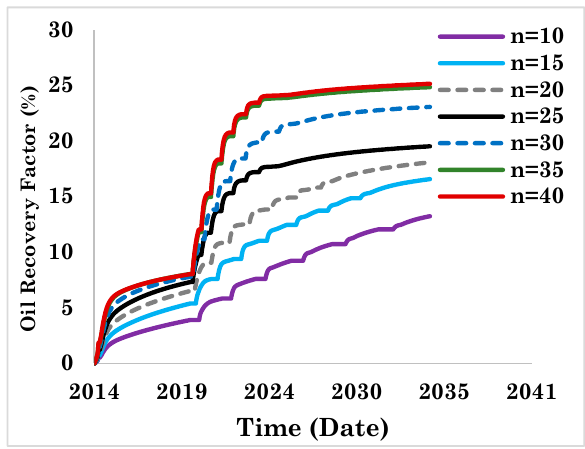
Figure 16. C 2 H 6 Injection (Fixed Cycle Size) 31 API Oil.